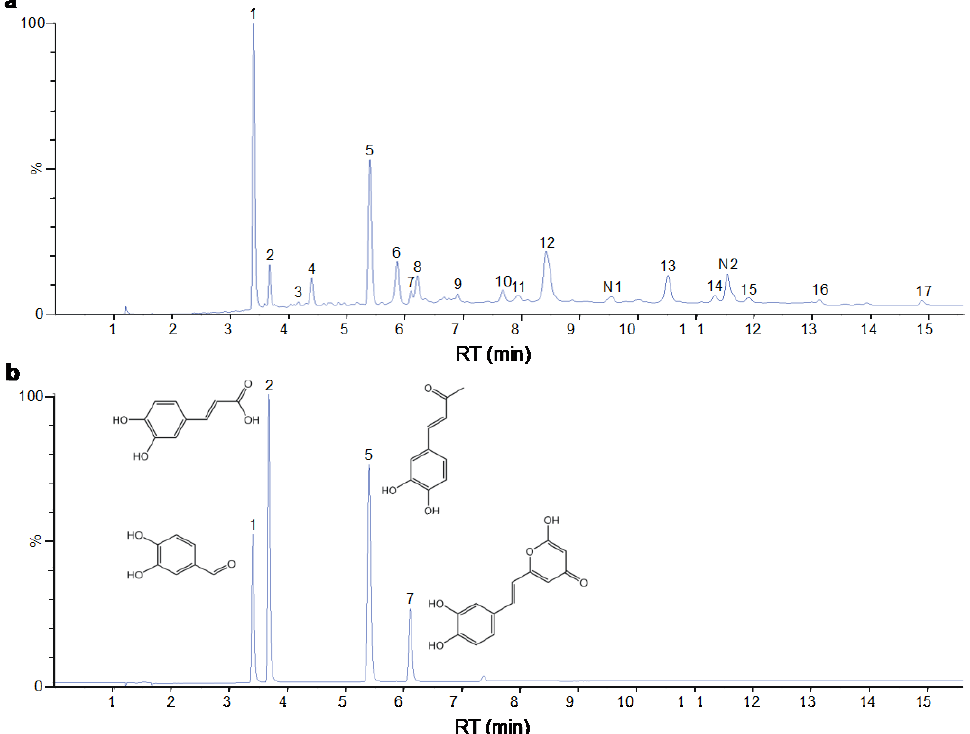
Figure 1. ( a ) UV chromatogram of PBP at 254 nm. ( b ) UV chromatogram of mixed standards of protocatechuic aldehyde, caffeic acid, osmundacetone and hispidin.